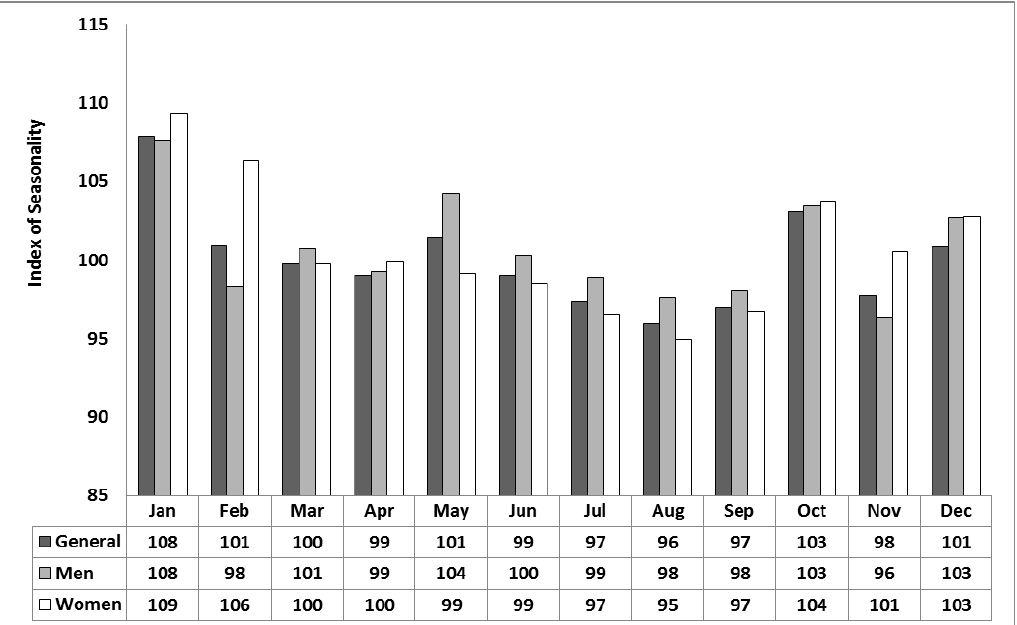
Figure 1. Monthly Index of Seasonality (IS) for Khabarovsk for the period 2000–2012 based on mean daily all-cause mortality for men, women and both men and women for all age groups.